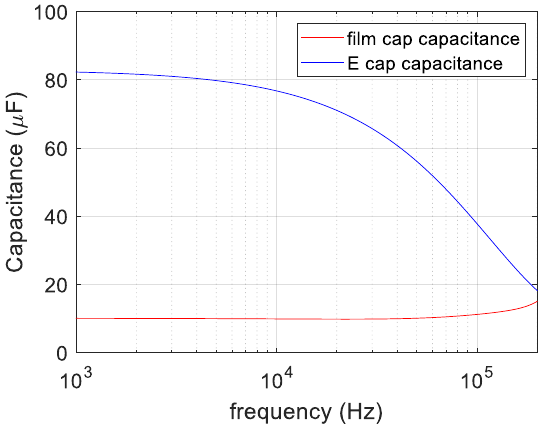
Figure 10. Frequency characteristics of capacitance values of the electrolytic and film capacitors used in the DC capacitor of VSI in electric compressor systems.